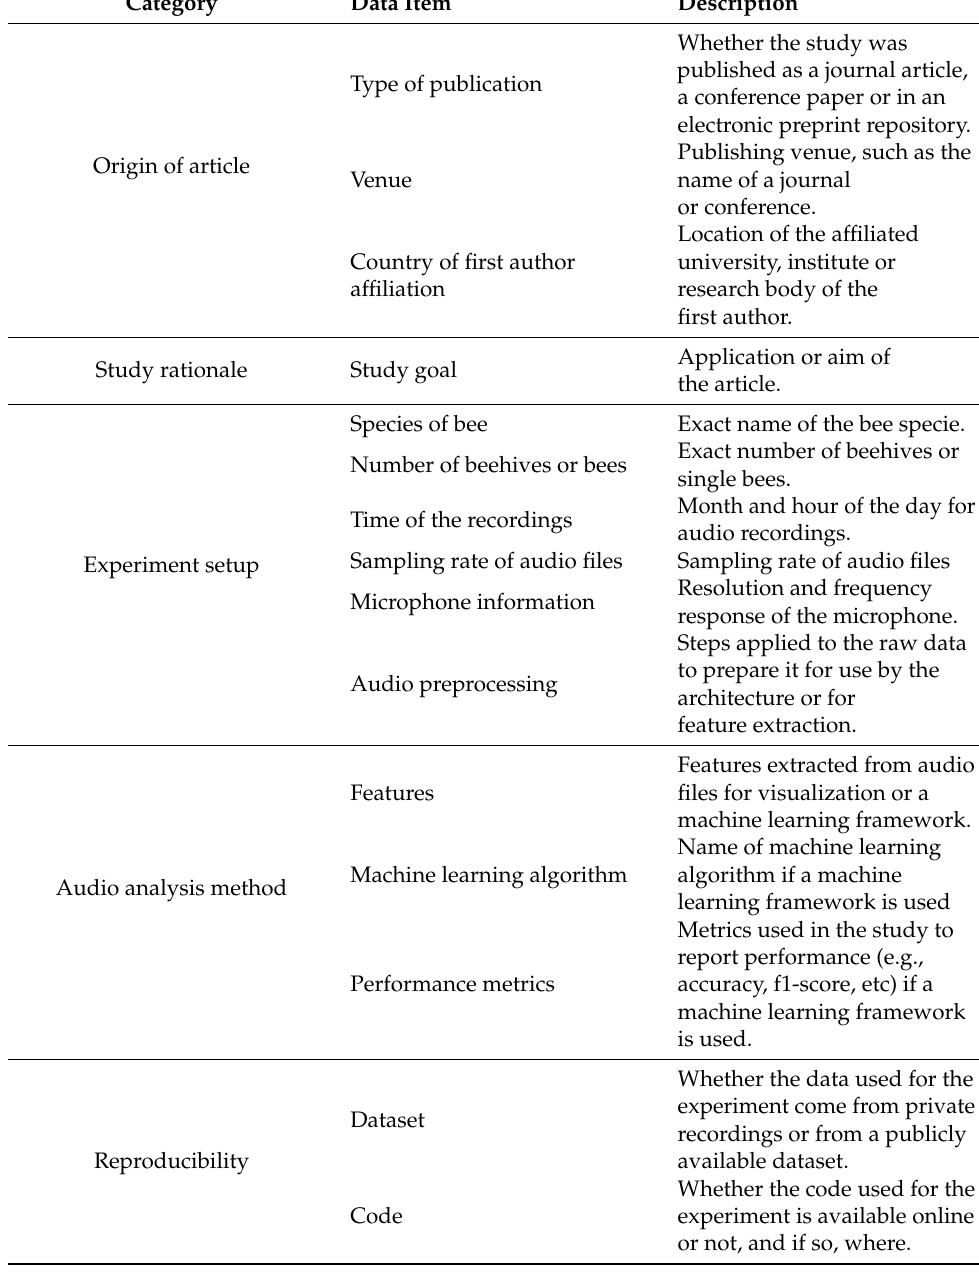
Table 2. Items extracted from each